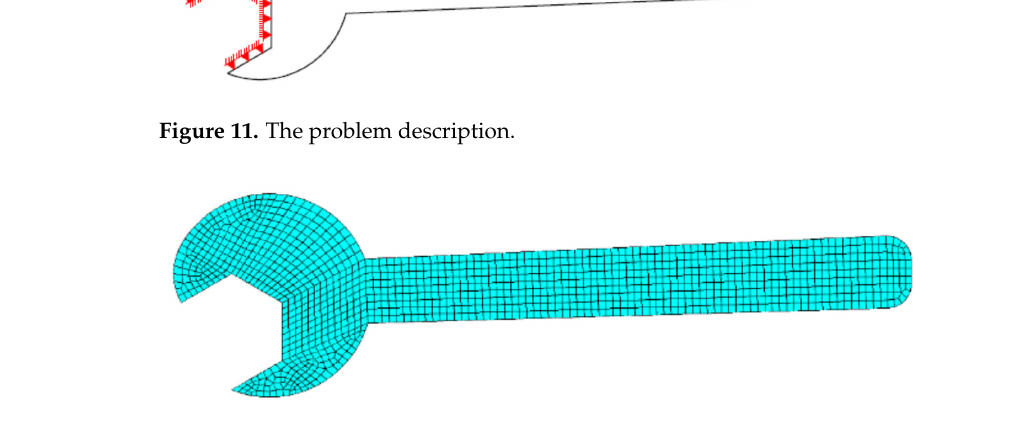
Figure 12. T-mesh of the wrench model.